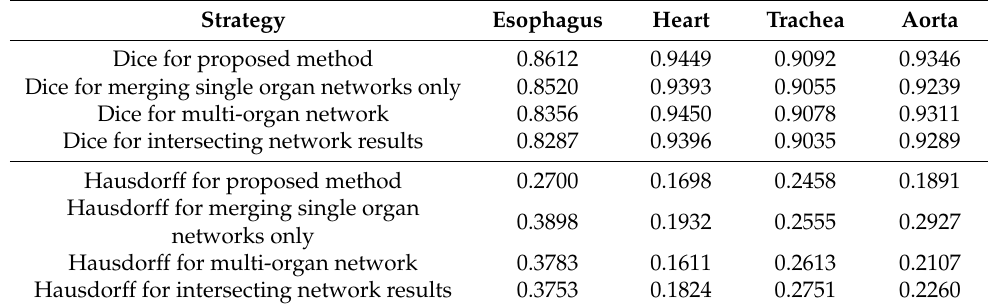
Table 4. Comparison between different